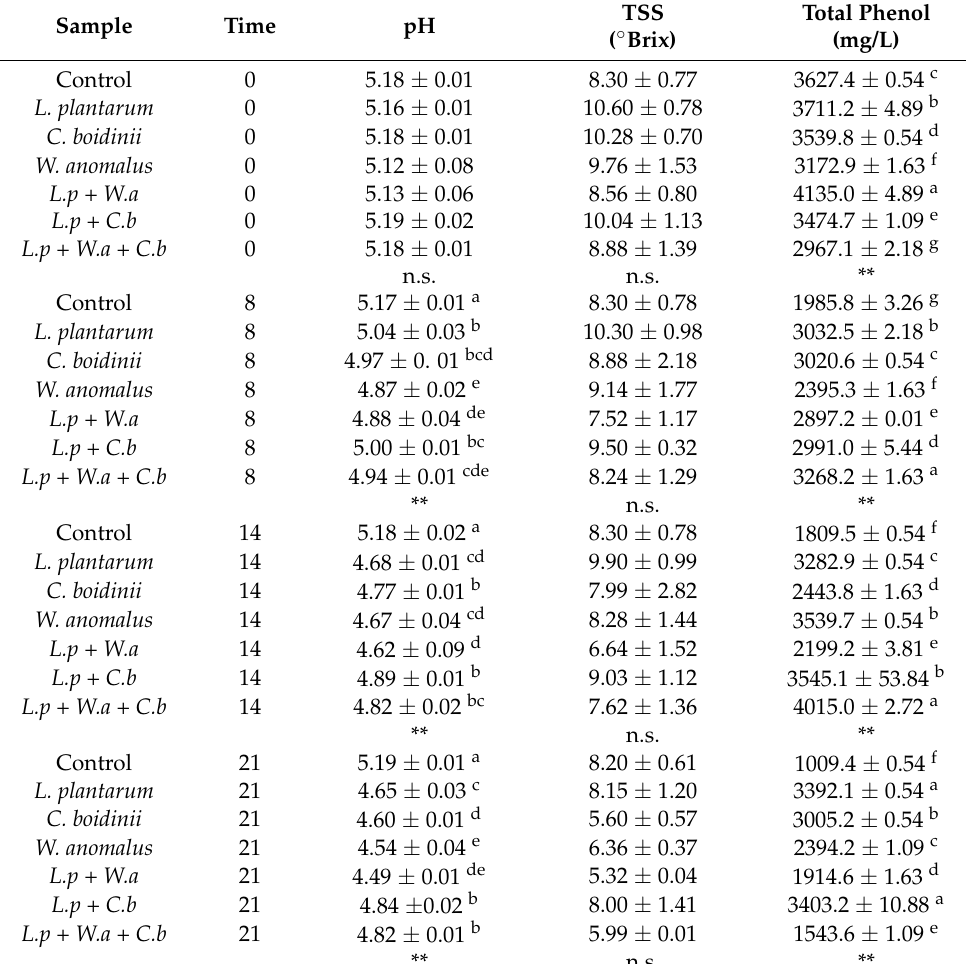
Table 1. Chemical parameters detected in samples of Trial